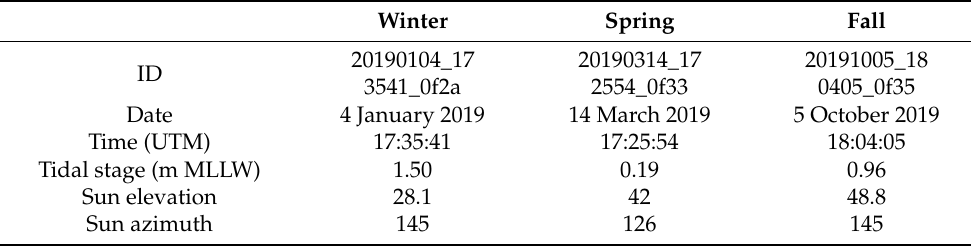
Table 1. Multispectral satellite imagery metadata. All images acquired by PlanetScope (4 bands, 3 m resolution) and downloaded at level ‘Analytic 3B’ [32]. Winter Spring